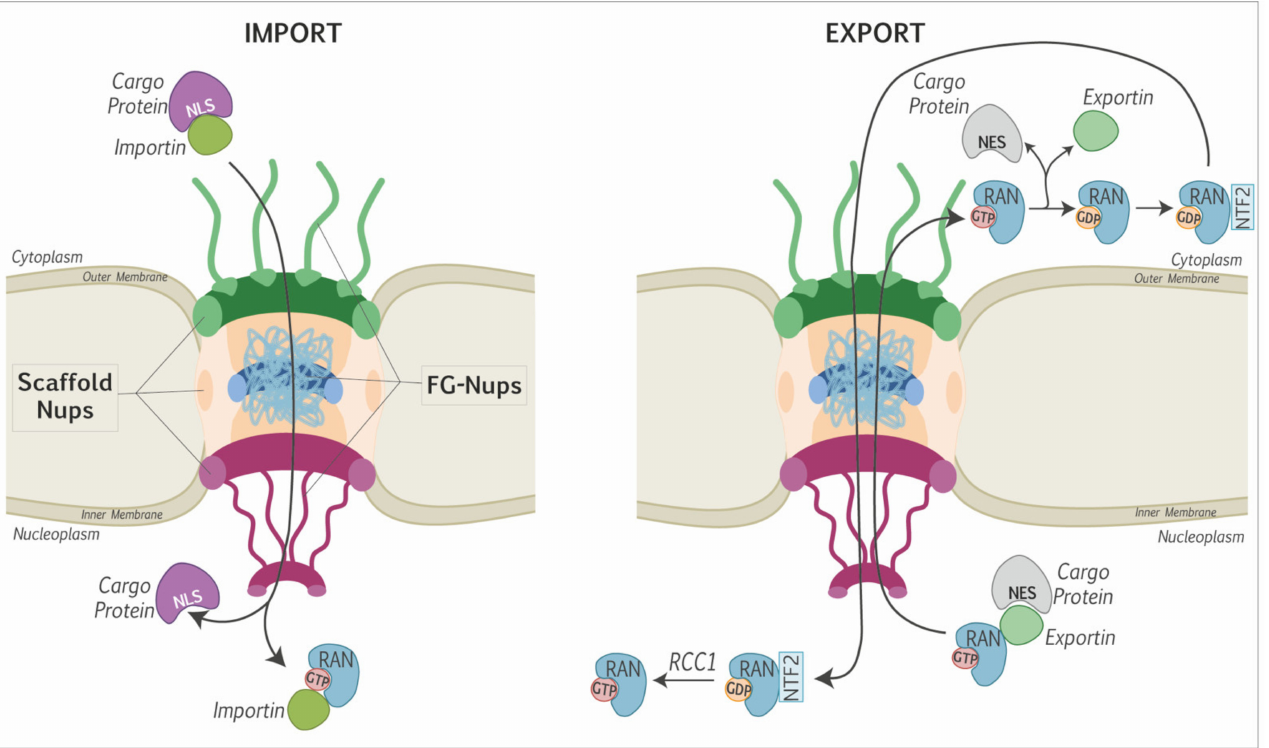
Figure 1. The nuclear pore complex and nucleocytoplasmic transport of proteins. Schematic representation of the nuclear pore: FG-Nups that interact with karyopherins: importins and exportins; and scaffold Nups that maintain the structure of the pore and its binding to the nuclear envelope. Left: nuclear import of a cytoplasmic protein. The NLS sequence of the cargo protein is bound by an importin, which drives the cargo through the pore by interacting with FG-Nups. In the nucleus, the binding of RAN-GTP to the importin frees the cargo protein. Right: export of a nuclear protein to the cytoplasm. The NES of the nuclear cargo protein is bound by an exportin complexed with RAN-GTP. The cargo-exportin-RAN-GTP complex translocates to the cytoplasm through the interaction of the exportin with the FG-Nups. Once in the cytoplasm, RAN-GTP is hydrolyzed into RAN-GDP, which induces the dissociation of the cargo-exportin complex. RAN-GDP is brought back to the nucleus by NTF2 and converted into RAN-GTP by the RAN guanine nucleotide exchange factor RCC1